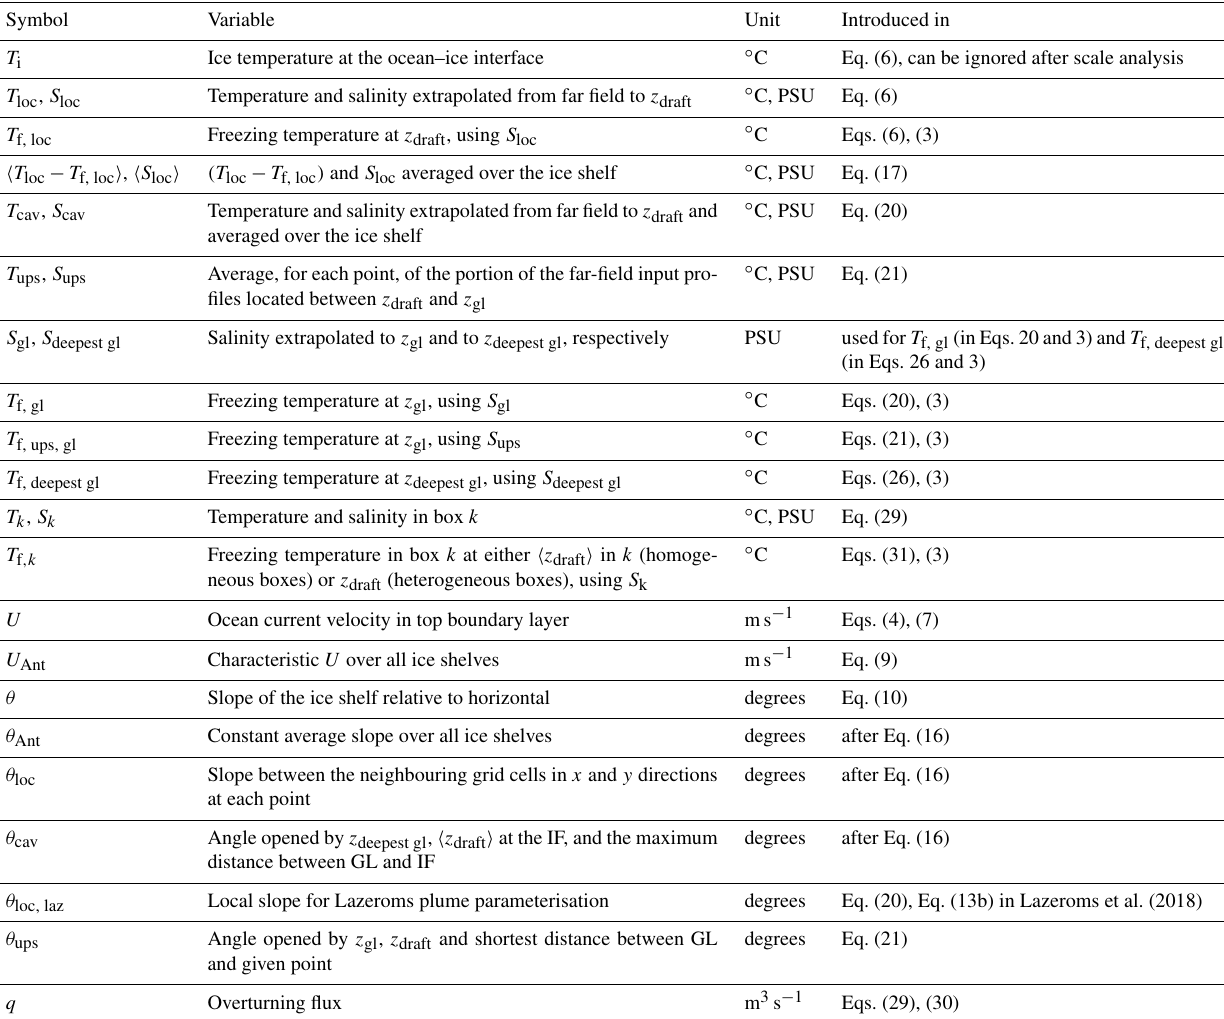
Table C1. Summary of definitions of physical variables used in the description of the melt parameterisations in Sect. 2.2. GL stands for grounding line; IF stands for ice